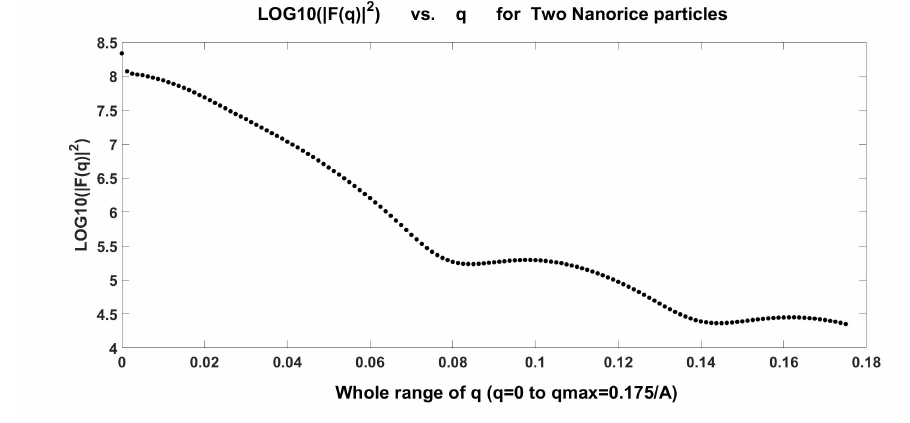
Figure 9. Logarithm of the intensities reconstructed from the angular correlations of two randomly spaced and oriented nanorice particles with widths of about 50